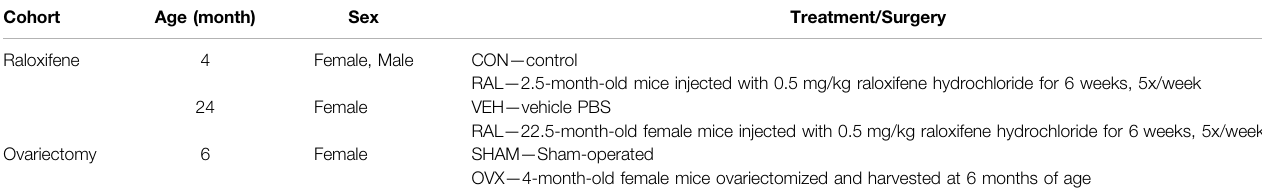
TABLE 1 | Experimental design.